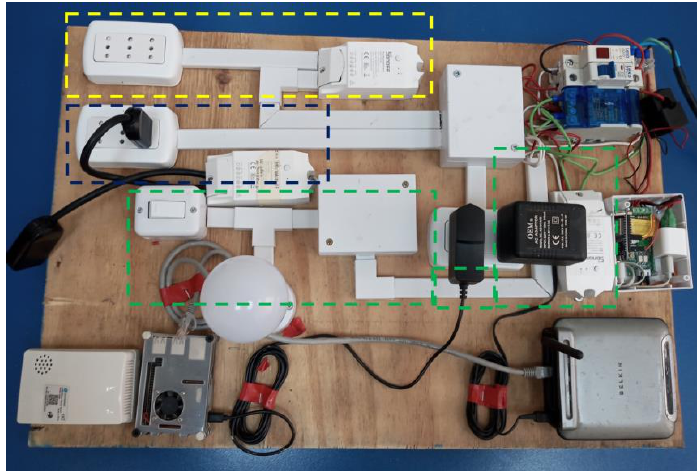
Figure 6. SThe schematic diagram for the testbed.